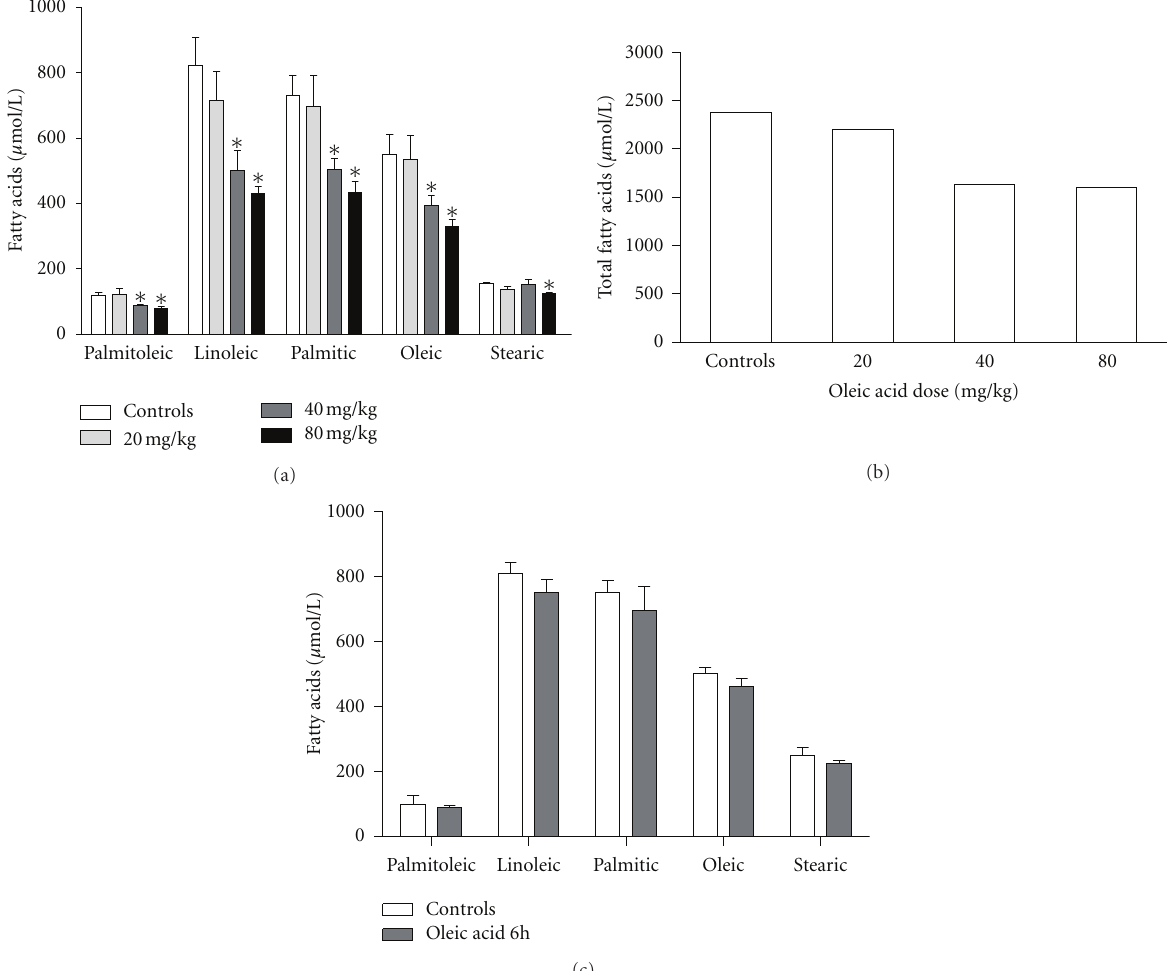
Figure 1: Plasma NEFA concentrations in mice after intravenous OLA injections. (a) Plasma concentrations of palmitoleic, linoleic, palmitic, oleic, and stearic acids 24 h after 20, 40, and 80mg/kg oleic acid doses (mean ± SEM of 5 di ff erent experiments). (b) Total NEFA concentration (sum of average concentrations of the five NEFA). All mice receiving the 160 mg/kg dose died 10–20 minutes after the intravenous injection and could not be computed. (c) Plasma concentrations of palmitoleic, linoleic, palmitic, oleic, and stearic acids 6 h after the injection of the 80mg/kg oleic acid dose (mean ± SEM of 4 independent experiments). ∗ P < 0 . 05 (versus controls).